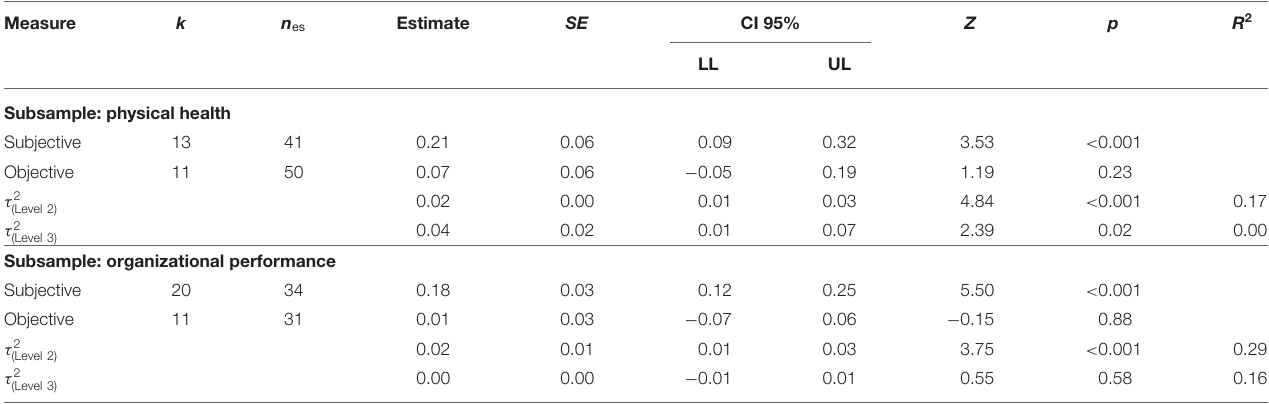
TABLE 4 | Results of moderated meta-analysis that compares subjective with objective outcome measures for different outcome categories.